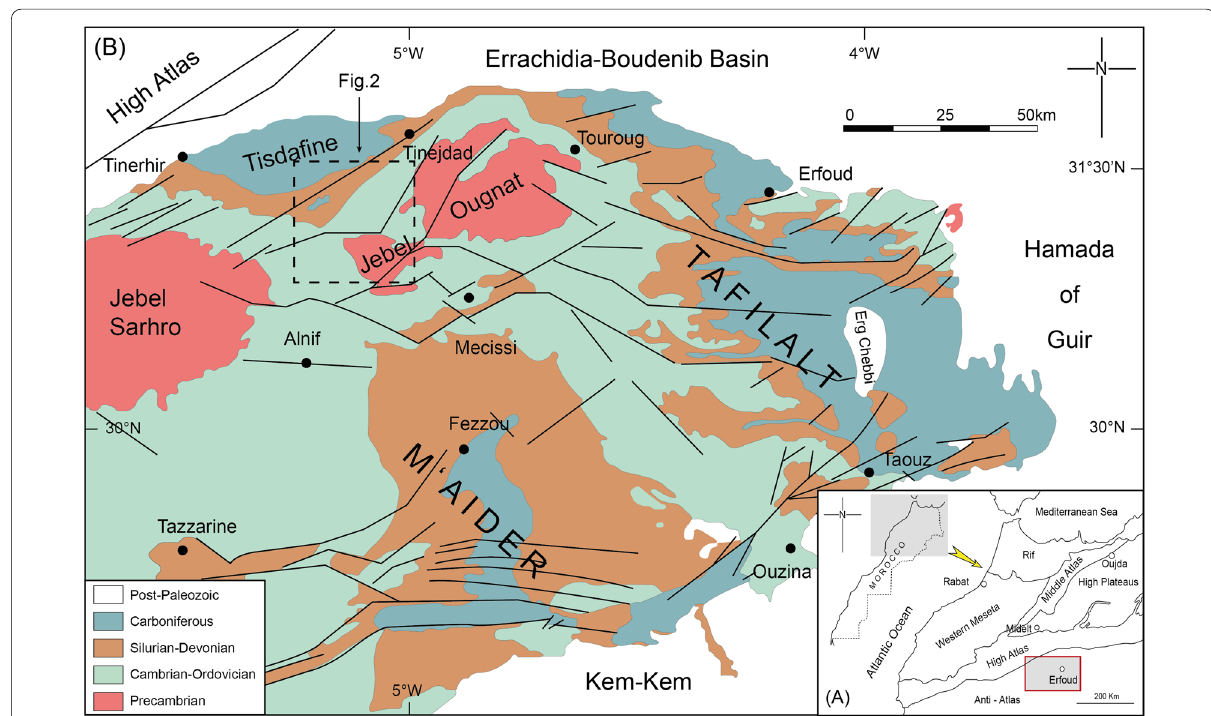
Fig. 1 Simplified geological map of the eastern Anti-Atlas (after Baidder et al., 2008, 2016; Michard et al., 2008), with location of the study area (surrounded by a square with a dashed line and reproduced in Fig.